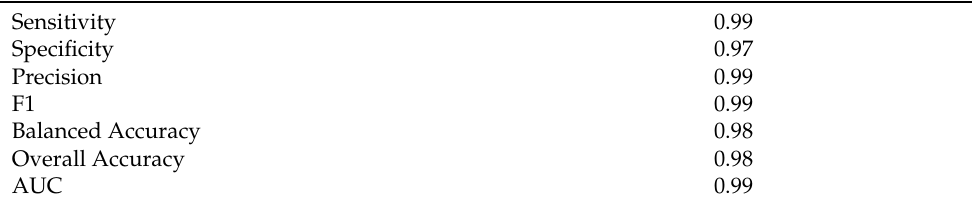
Table 3. Performance metrics for the binary outcome